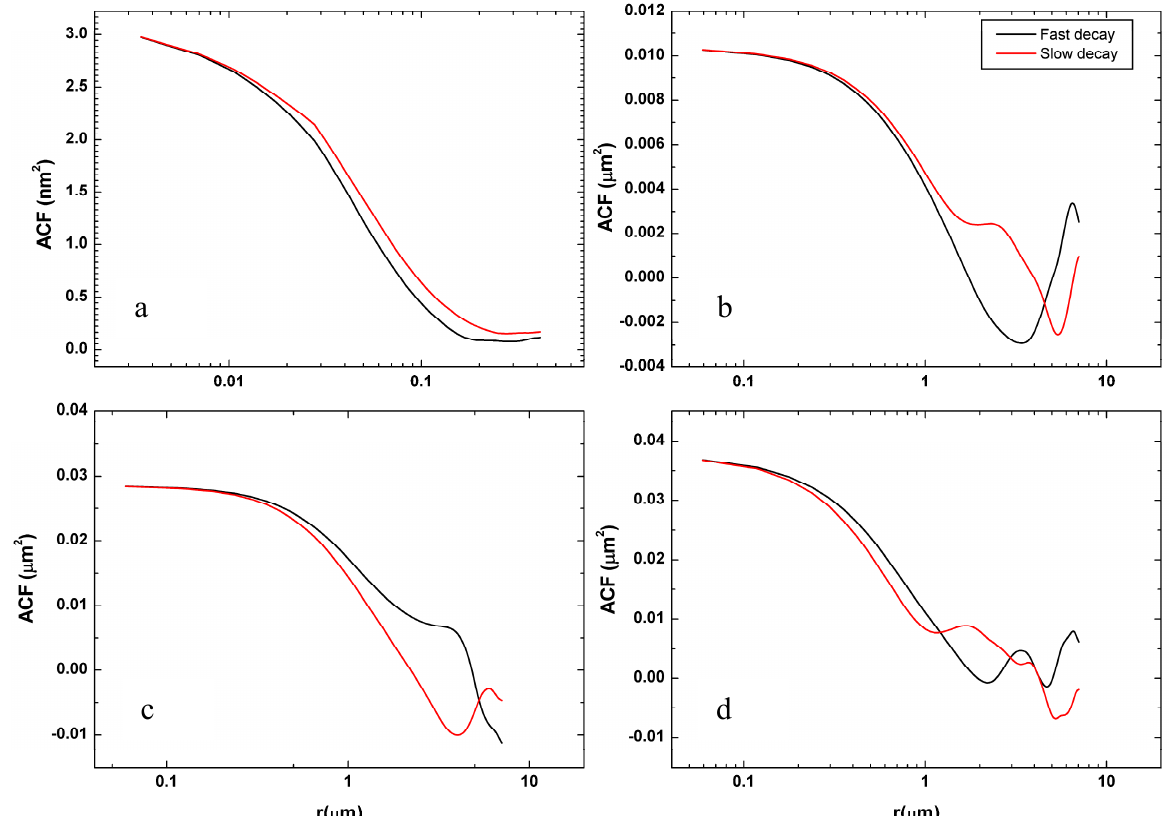
Figure 3. ACFs graphs as a function of the sample length (r) of ( a ) ITO, ( b ) 5 cycles, ( c ) 15 cycles, and ( d ) 25 cycles. Table 2. Corresponding values of τ a 1 , τ a 2 , S a 1 , S a 2 , and Str for the samples.